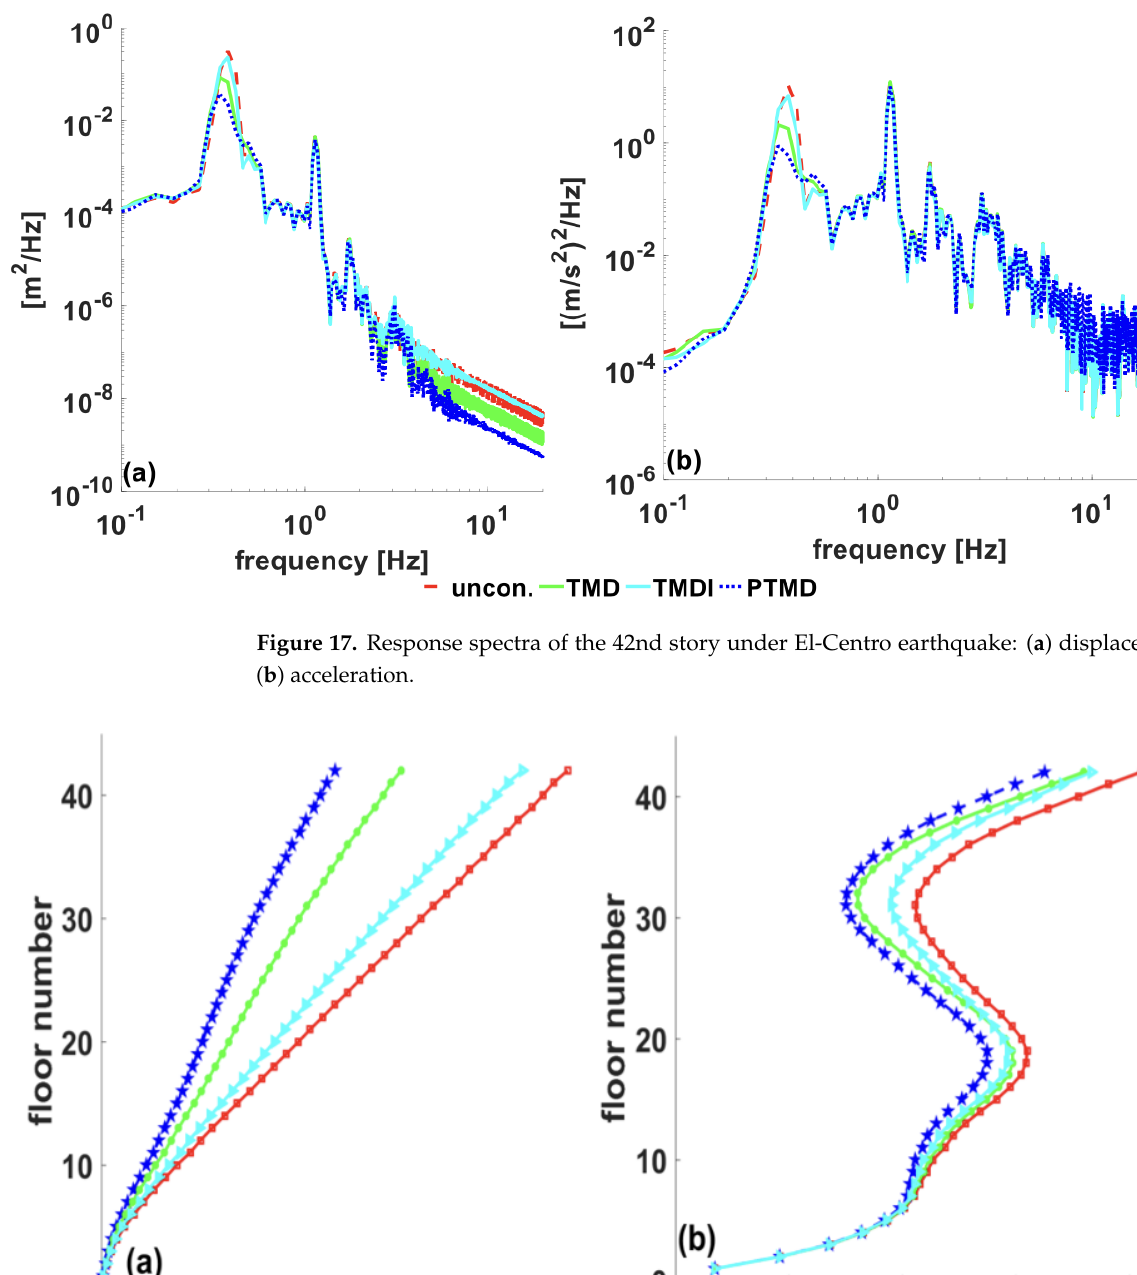
Figure 16. Uncontrolled and controlled displacement and acceleration responses of the 42nd floor, in the time domain, under El-Centro earthquake excitation: ( a ) displacement response and ( b ) ac- celeration response.